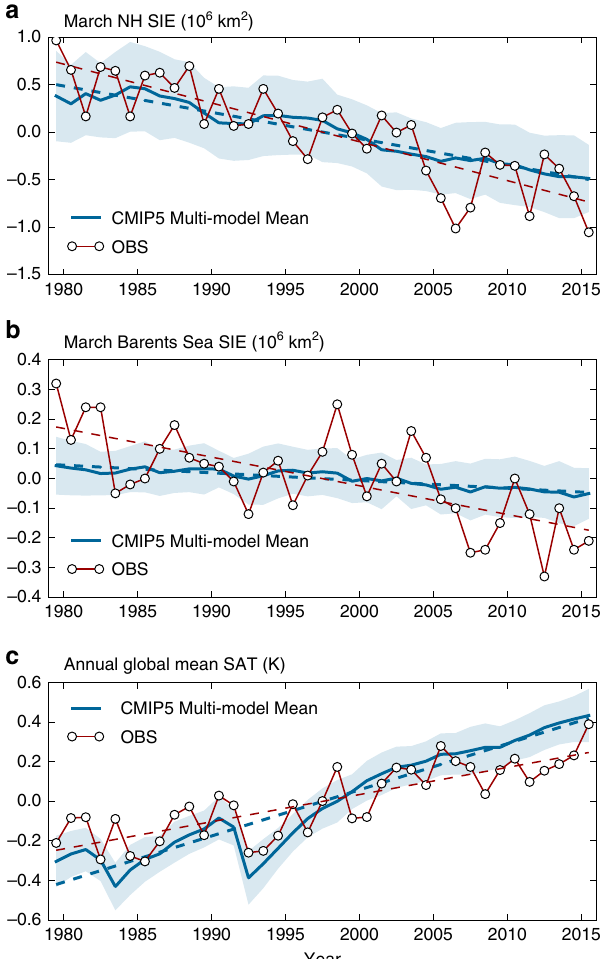
Figure 1 | Observed and CMIP5 multi-model-simulated time series. ( a ) March NH SIE anomaly ( b ) March Barents Sea SIE anomaly ( c ) Annual global mean SAT anomaly. Blue solid line: CMIP5 multi-model ensemble mean; light blue shading: spread ( ± 1 s.d.) across multi-model ensemble members; blue dashed line: linear trend. Observations (SIE from NSIDC and SAT from the average of three reanalysis datasets—NCEP/NCAR, ERA- Interim and MERRA) and their linear trends are shown in red solid lines with circle markers and red dashed lines,